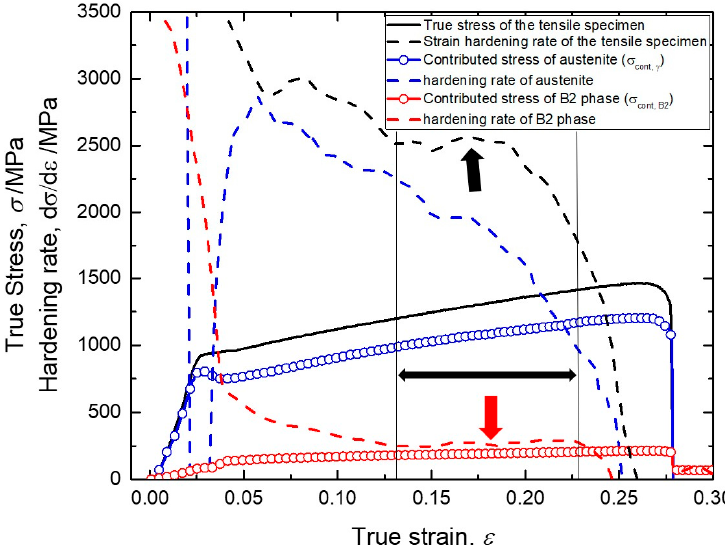
Figure 9. The contributed flow stress of austenite phase and B2 phase, the experimental tensile flow stress, and their slopes are plotted as a function of the tensile true strain. The region indicated by the double arrow corresponds to where the decreasing of the hardening rate of B2 phase (red dashed line) slowed down, so that the decreasing of strain hardening rate of the tensile test specimen (black dashed line) in the region was slowed down.